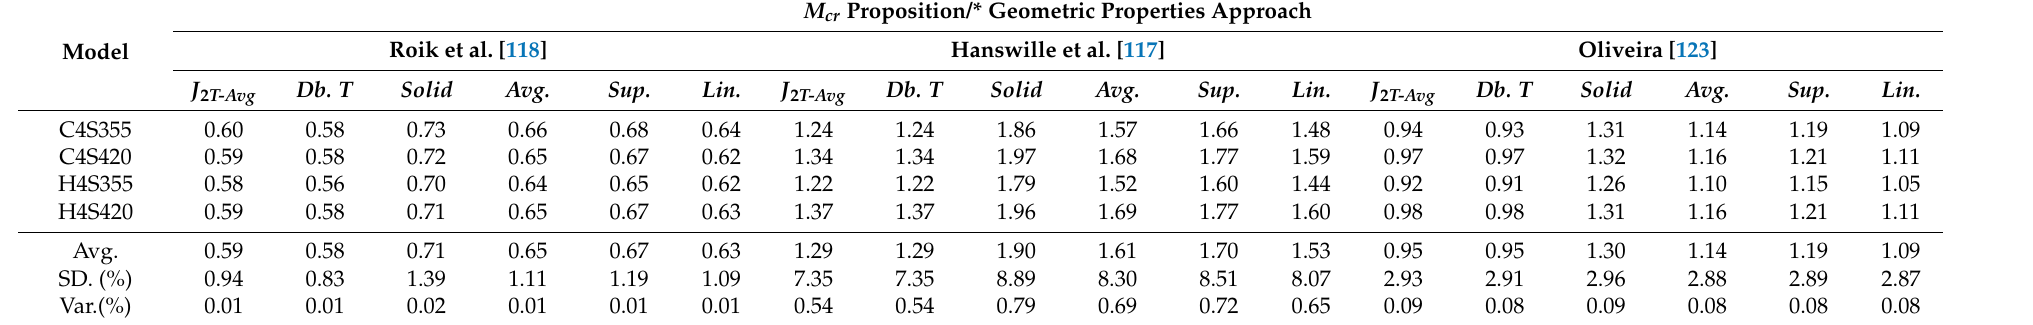
Table 13. M u-Theoretical / M u-test obtained by the calculation procedure of EN 1994- 1-1: 2004 [107].